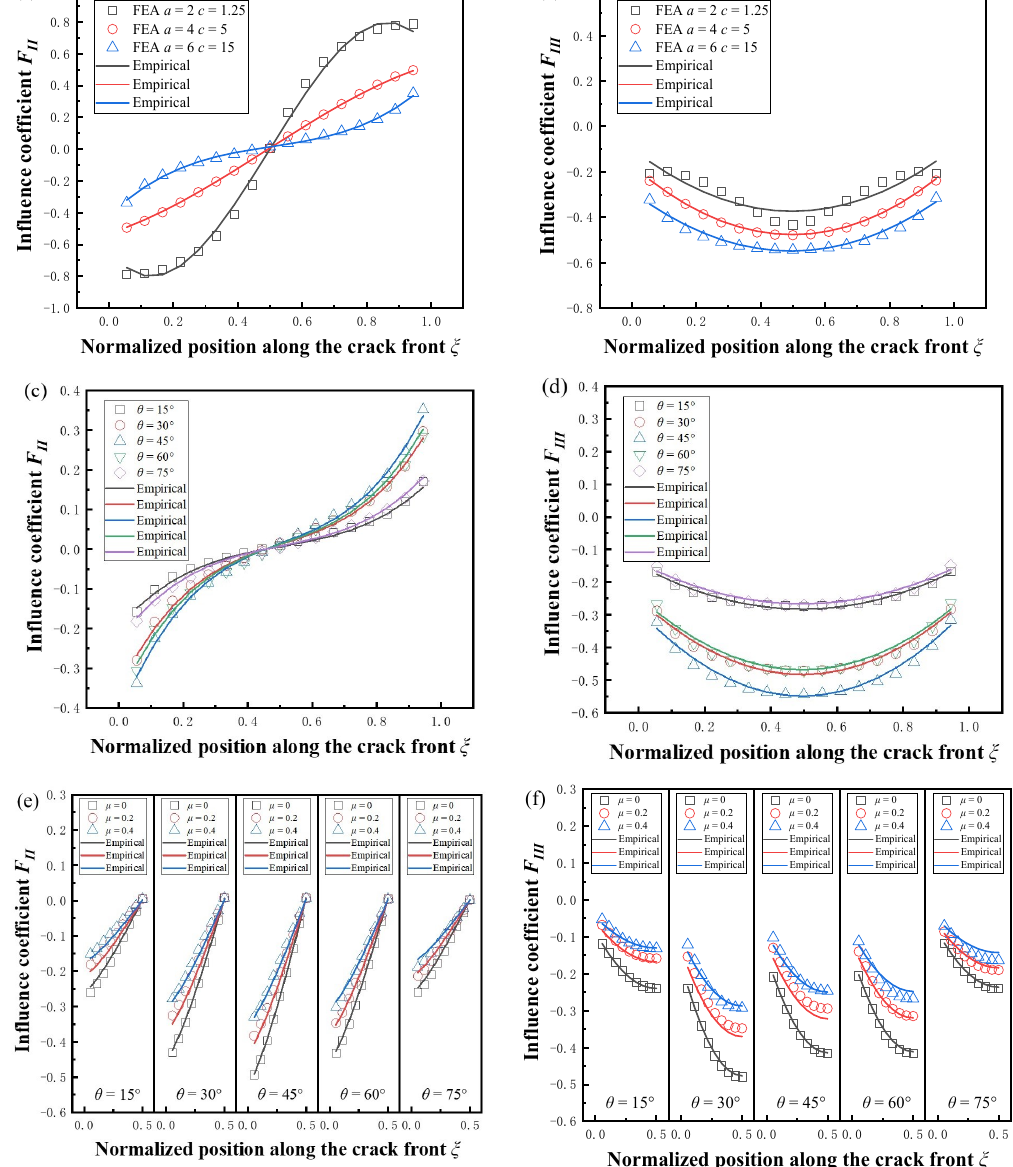
Figure 12. Comparison of SIFs fitting results with ( a , b ) different crack sizes ( a/t = 0.2, 0.4, 0.6, a/c = 1.6, 0.8, 0.4, θ = 45°, μ = 0); ( c , d ) different inclination angles ( a/t = 0.6, a/c = 0.4, μ = 0); ( e , f ) different friction coefficients ( a/t = 0.4, a/c = 0.8, μ = 0, 0.2, 0.4).